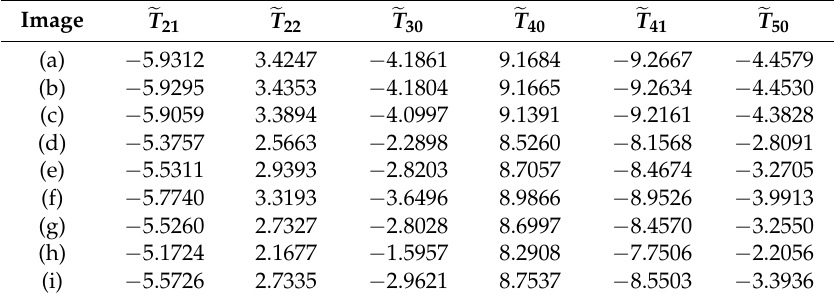
Table 2. Tchebichef moment invariants of the candidate images in Figure 4.